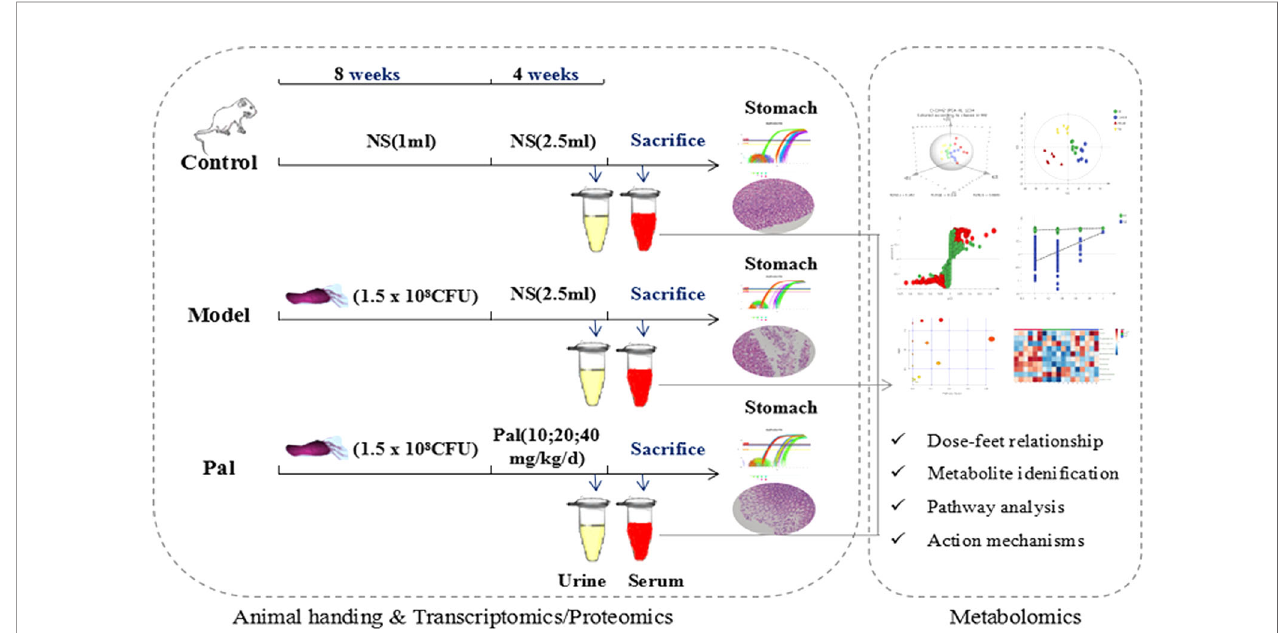
FIGURE 1 | Scheme of the